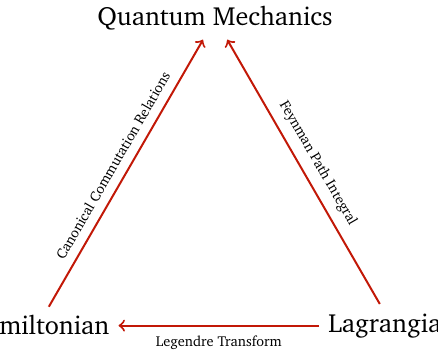
Figure 8: Illustration of the relationship between different formalisms of quantum and classical